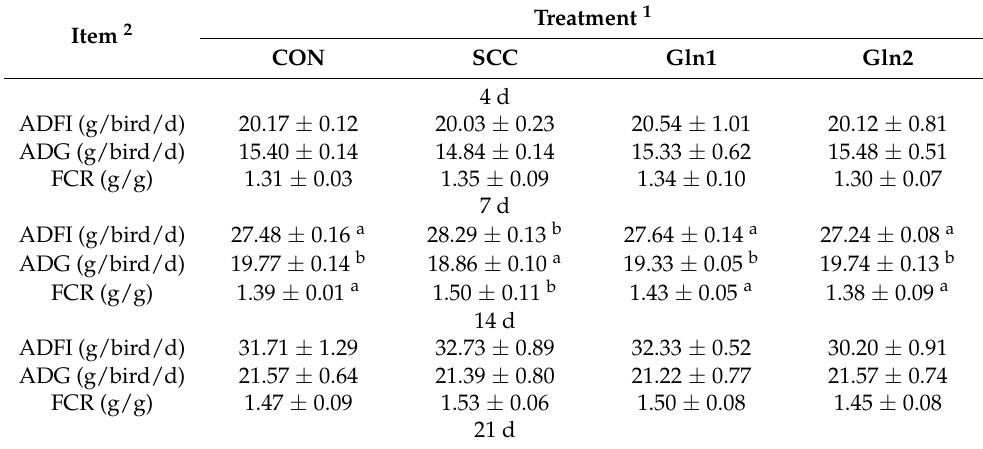
Table 3. Effect of Gln on the growth performance of broiler chickens that received S . Enteritidis. Item